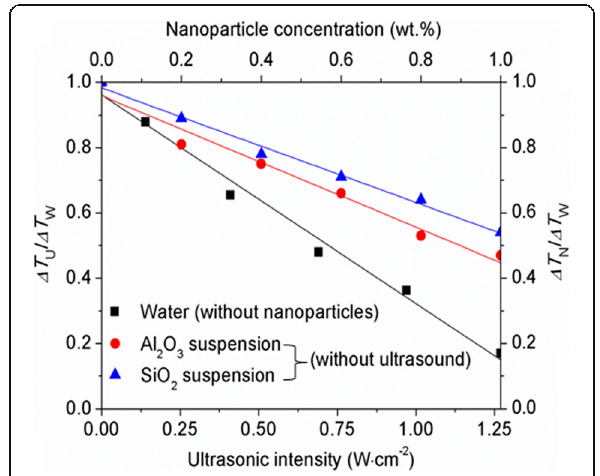
Fig. 3 Effects of ultrasound and nanoparticles on the supercooling degree of water. Δ T U / Δ T W represents the ratio of supercooling degree required for the water solidification with ultrasound to that without ultrasound. Δ T N / Δ T W represents the ratio of supercooling degree required for the water solidification with nanoparticles to that without